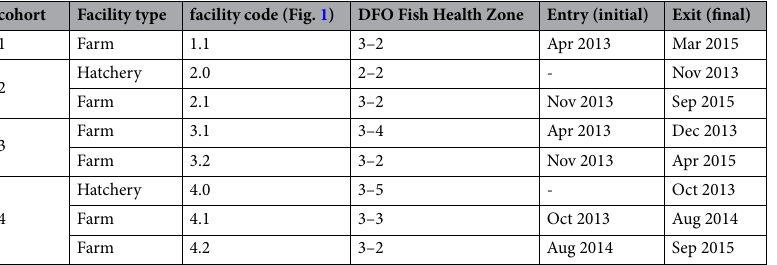
Table 1. Movement history for farmed Atlantic salmon used in this study. Geographic locations of individual facilities are shown in Fig. 1.